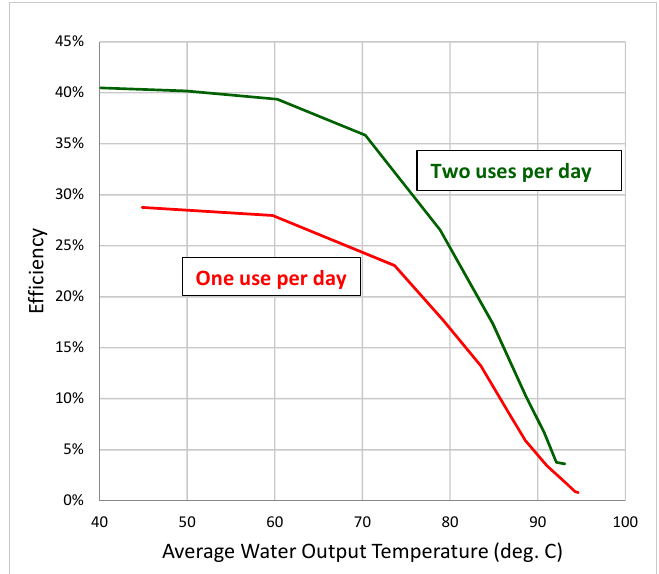
Figure 6. Marginal efficiency vs. average water output temperature for a DDS cooker used as a water heater. Here, we measure performance reliability in terms of the average temperature of the water heated in the cooker when it is drawn from the cooker. On cloudy days, the DDS cooker does not heat its contents to boiling temperature by the time the water is drawn. A system with a large solar panel (and low utilization efficiency) reliably heats the cooker contents to near-boiling tem-